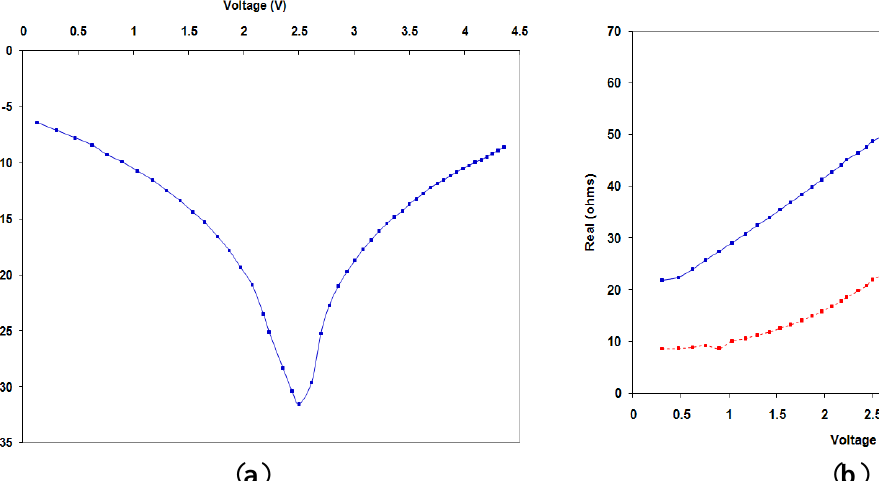
Figure 7. ( a ) change of S11 as supercapacitor charges at 6 dBm; ( b ) Impedance change as supercapacitor